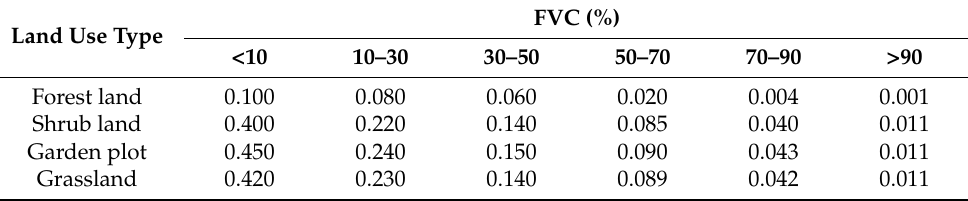
Table 3. C values of different land use types considering the